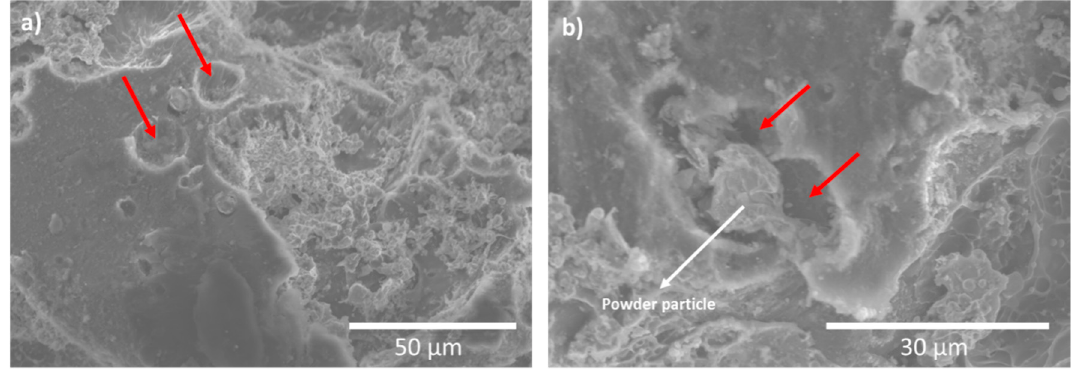
Figure 3. ( a ) and ( b ) SEM-micrographs of HVOF sprayed WC-Co particles on ZE41 magnesium